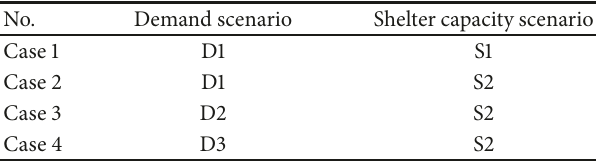
Table 9: Information of combination of different scenarios. Table 10: Feasible lane distribution scheme and link flow in Case 1 when 𝜇 = 1.11